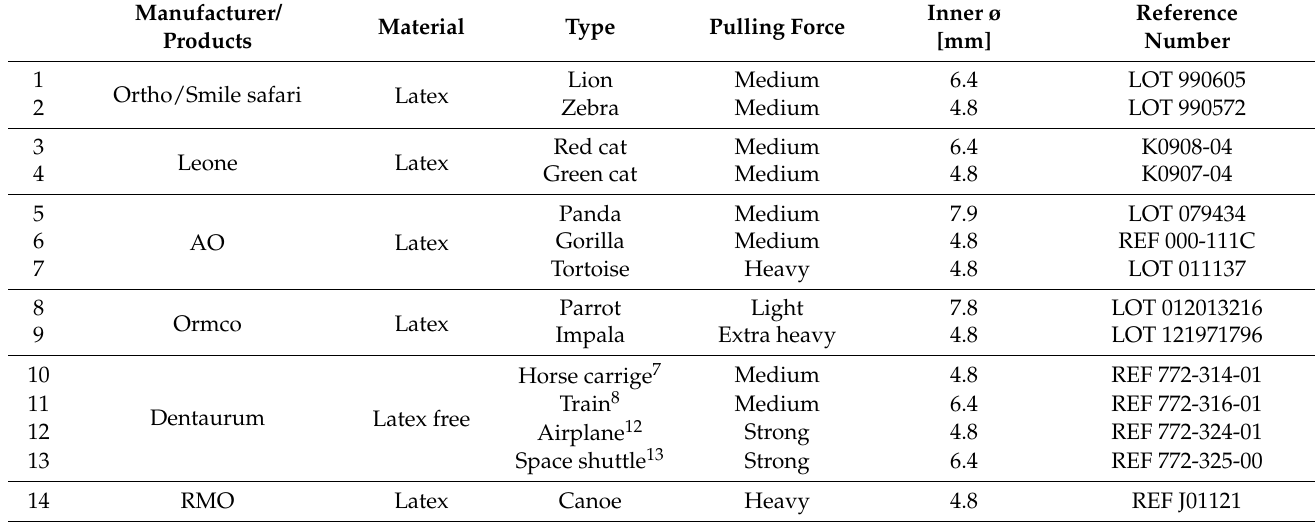
Table 1. Main parameters of the tested ligatures according to the technical data